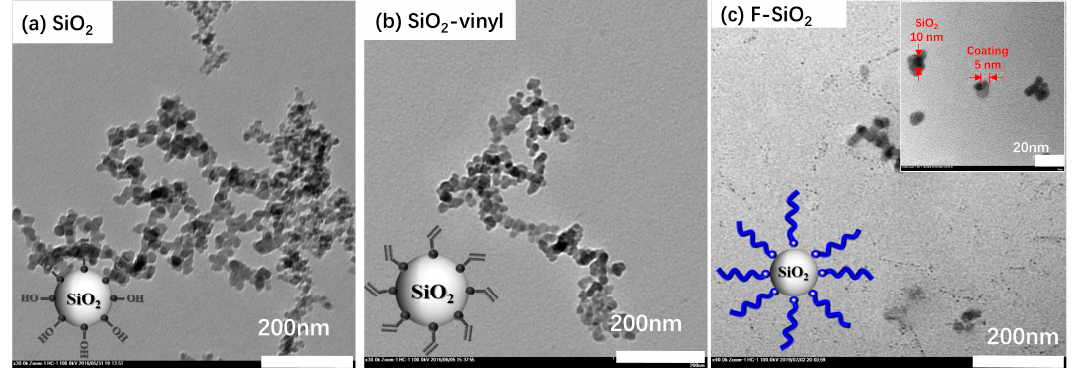
Figure 4. TEM image of the SiO 2 ( a ), SiO 2 -vinyl ( b ), and F-SiO 2 ( c